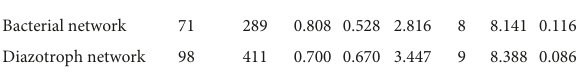
TABLE 2 Topological properties of the co-occurring networks of bacterial and diazotroph